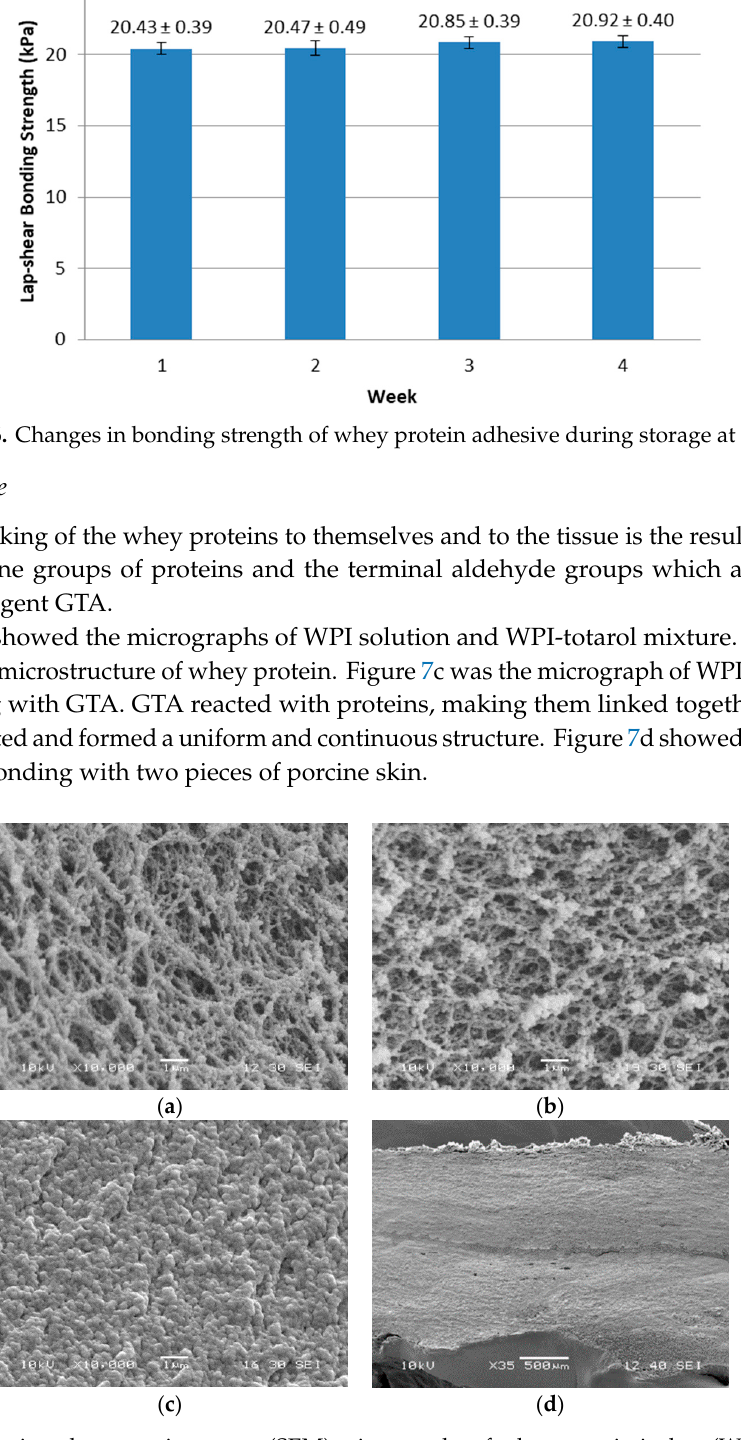
Figure 7. Scanning electron microscopy (SEM) micrographs of whey protein isolate (WPI) solution (33% protein) ( a ), WPI solution (33% protein) containing 0.2% totarol ( b ), WPI solution (33% protein) containing 0.2% totarol crosslinked by 14% glutaraldehyde ( c ) at 10,000× magnification, and porcine skins bonded by tissue adhesive at 35× magnification ( d ).